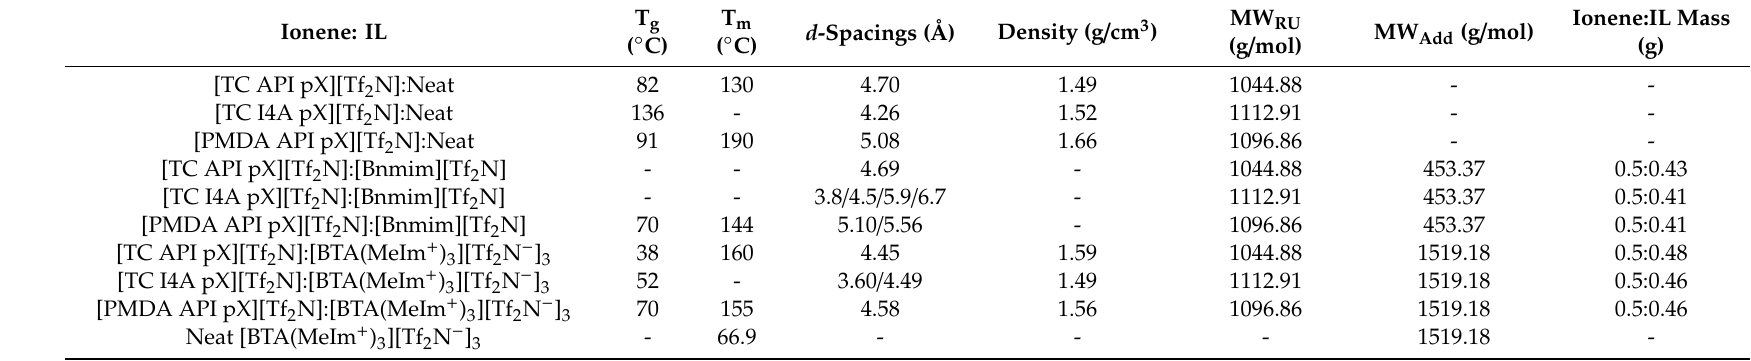
Table 2. Summary of characterization data for PA and PI composites with [Bnmim][Tf 2 N] and [BTA(MeIm + ) 3 ][Tf 2 N − ] 3 , and composite